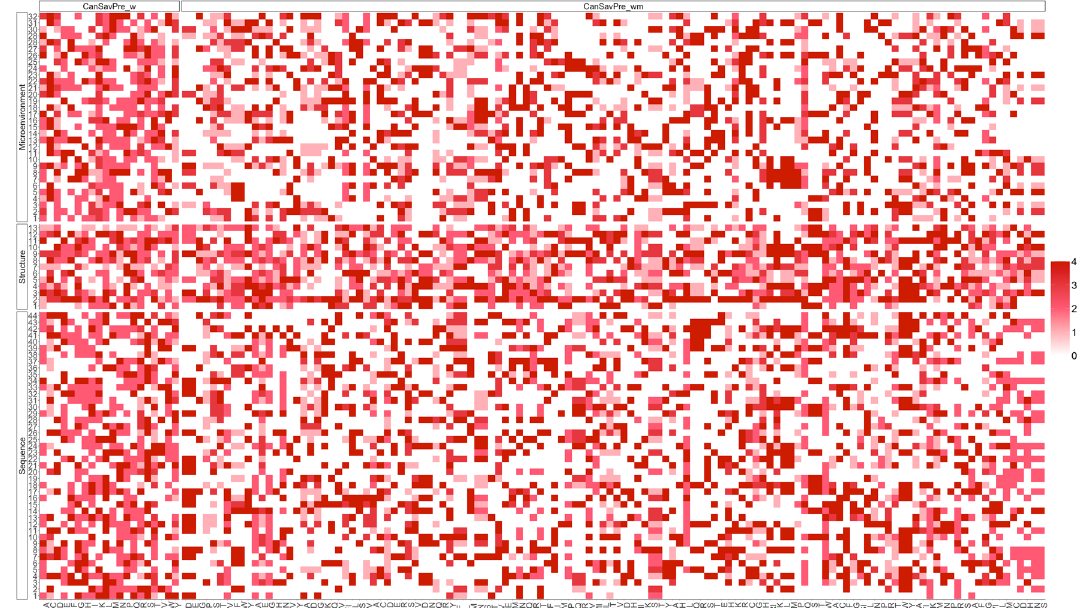
Figure 8. The heatmap of selected features in each training group of two prediction systems.